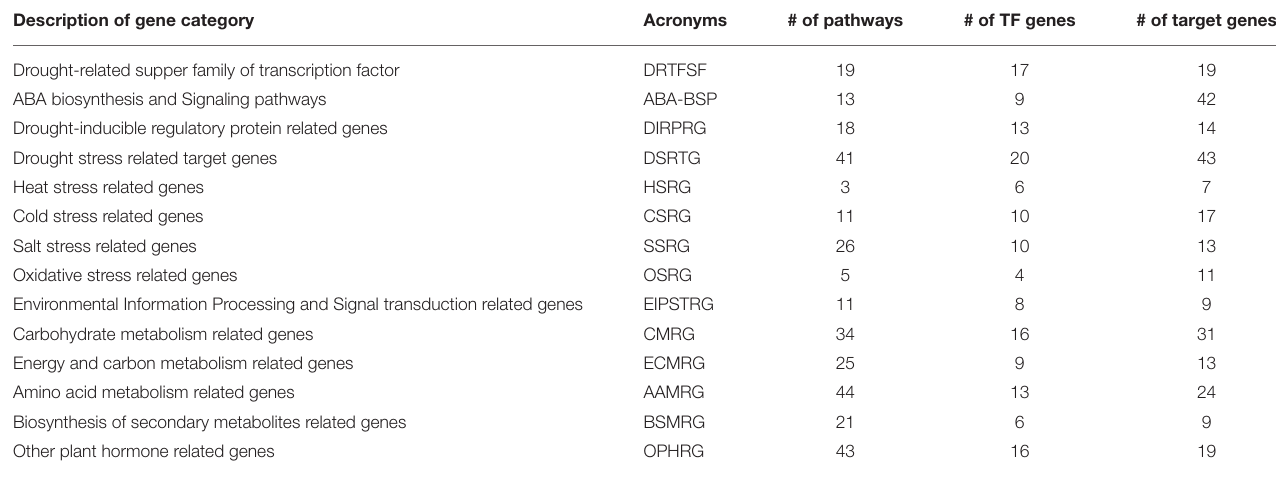
TABLE 3 | Description of DSRhub genes and the corresponding pathways involved and the transcription factor or regulatory genes categories. Description of gene